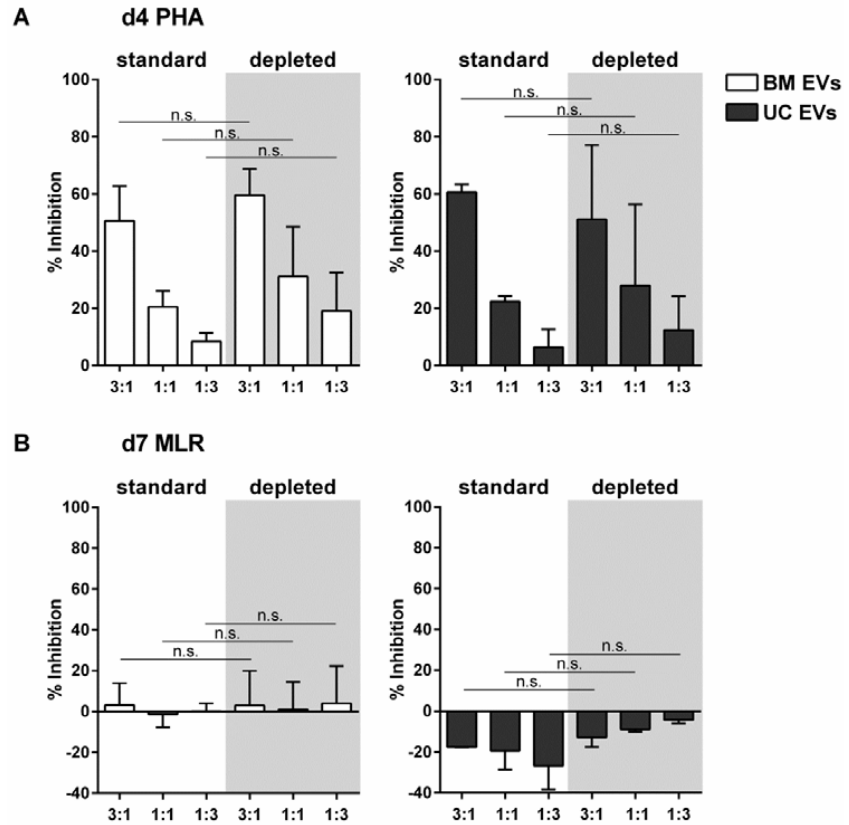
Figure 3. EVs released by MSCs under pHPL-EV-depleted culture conditions still retain the potential to inhibit T-cell proliferation. EVs were derived from BM-MSC donor C or UC-MSC donor D either under standard medium conditions (standard) or under pHPL-EV-depleted medium conditions (depleted, grey background). Pooled CFSE pre-labeled PBMCs were stimulated with 5 µg/mL PHA ( A ) or via MLR ( B ) and co-cultured with different amounts of MSC-EVs in triplicate (depicted ratios: EVs from cell number MSCs:cell number PBMCs). At Day 4 (d4), all EV preparations exhibited inhibition of PHA-induced T-cell proliferation in a dose-dependent manner (A). At Day 7 (d7), BM-MSC-derived EVs had minor MLR inhibitory effects, which were not dose-dependent. UC-MSC-derived EVs had an MLR stimulatory effect, which also was not proportional to the given EV amounts (B). The mean ± SD of preparations tested in triplicate from two experiments is shown (n.s.: not significant).